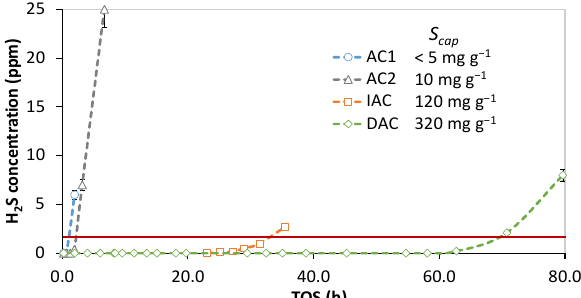
Figure 4. Relative sulfur capture capacity of activated carbon-based adsorbents in syngas with a feed of 70 ppm H 2 S, 3000 ppm oxygen, and 50% RH and SV 16,000 h −1 (reactor 1). AC1 and AC2: non-impregnated activated carbon; IAC: impregnated activated carbon; DAC: doped activated carbon. Particle size distribution—0.5–0.85 mm.